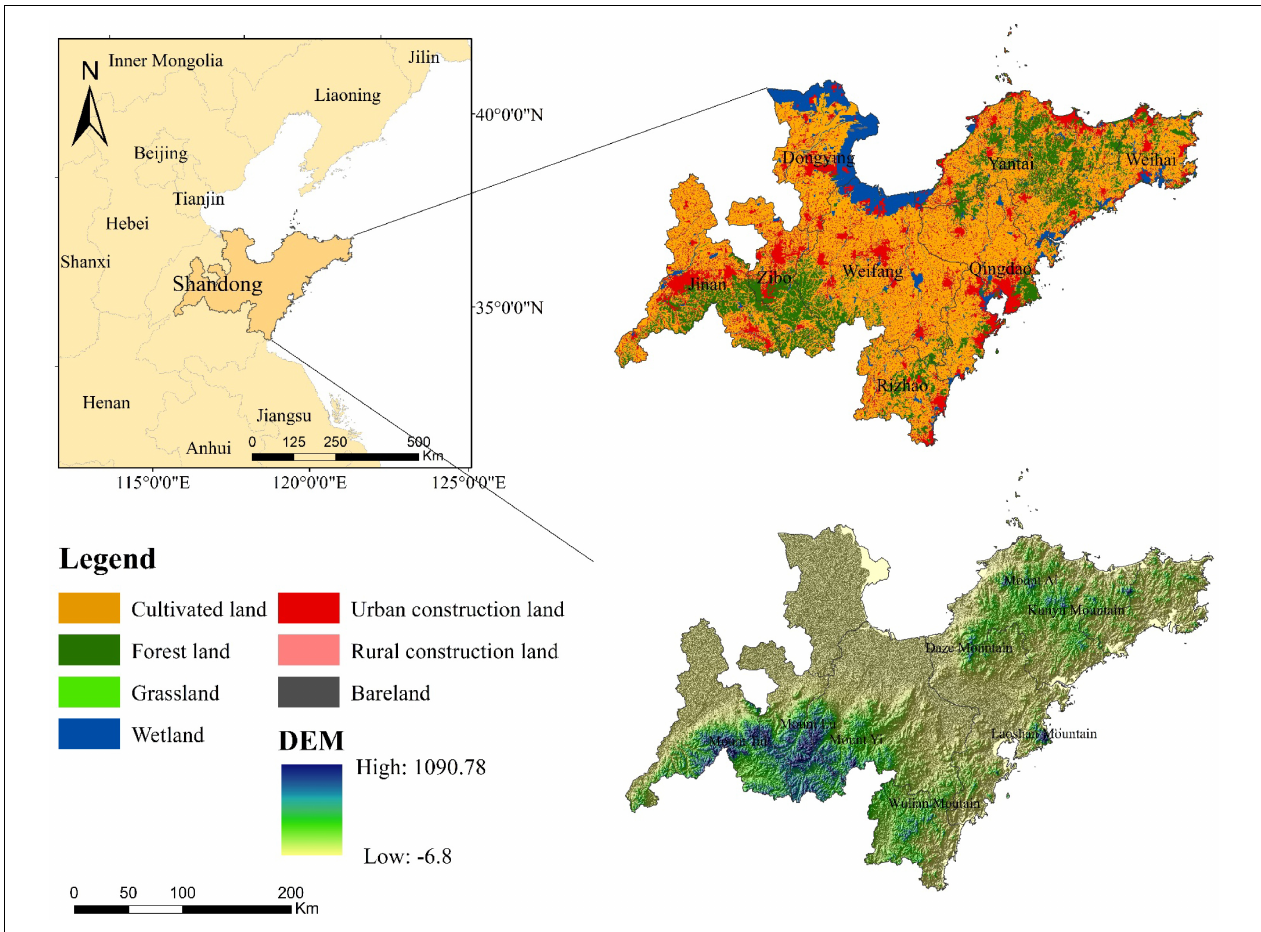
FIGURE 2 | Land use types and geographical location of Shandong Peninsula urban